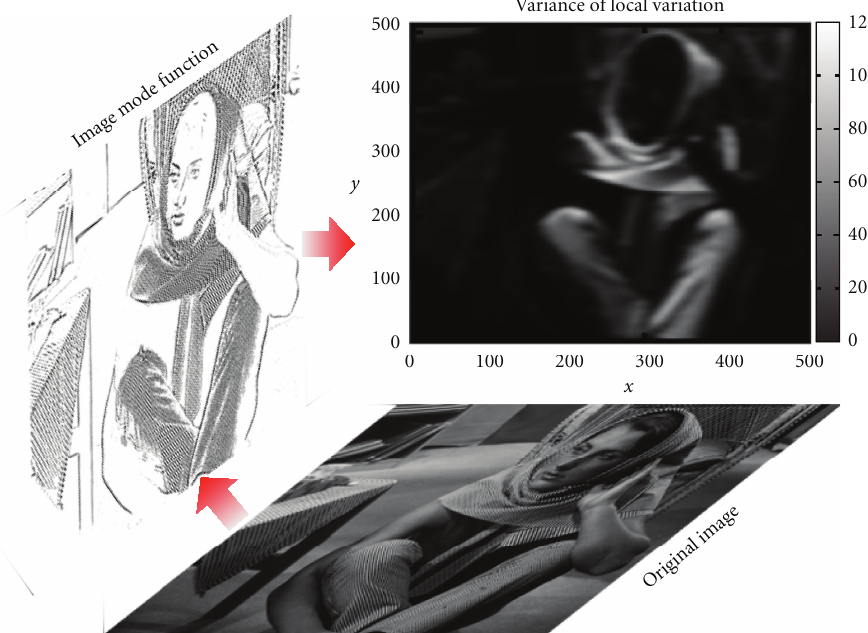
Figure 4: Adaptive PDE transform for selective texture extraction in the Barbara image. The variance of the local variation is shown in the top